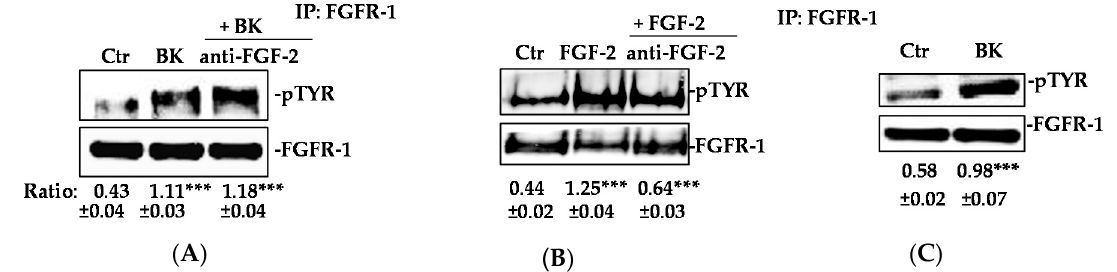
Figure 4. BK phosphorylates FGFR-1 despite the absence of FGF-2. ( A , B ) HUVEC were treated with anti-FGF-2 neutralizing antibody (6 µg/mL), then stimulated with FGF-2 (20 ng/mL), as a positive control or BK (1 µM) for 10 min. FGFR-1 was immunoprecipitated (IP), and its activation was investigated by anti-pTYR antibody. Results were normalized to FGFR-1. *** p < 0.001 vs. Ctr (control, 0.1% FBS). ( C ) Murine EC was isolated from FGF-2 − / − mice were stimulated with BK (1 µM) for 10 min. FGFR-1 was immunoprecipitated (IP), and its activation was investigated by an anti-pTYR antibody. Results were normalized to FGFR-1. The results presented are representative of three independent experiments ( n = 3) with similar results. *** p < 0.001 vs. Ctr (control, 0.1% FBS).